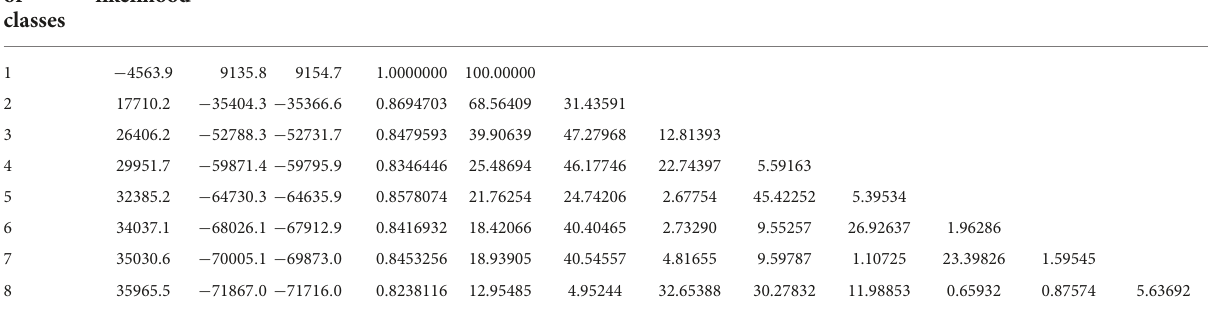
TABLE 2 Statistics for choosing the best number of classes. Number